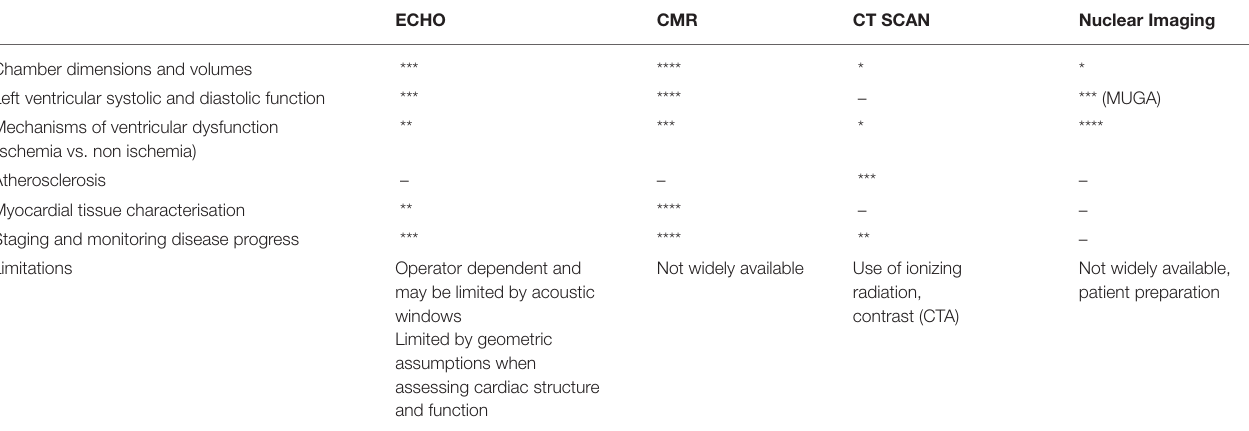
TABLE 1 | Clinical and investigational utility of cardiac imaging modalities in HIV associated